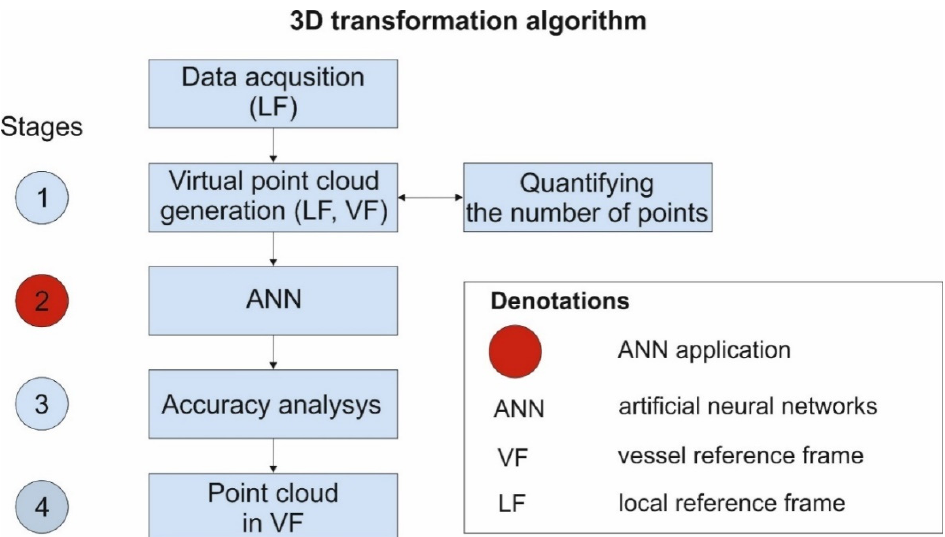
Figure 1. Coordinate transformation algorithm for offshore purposes using ANN.